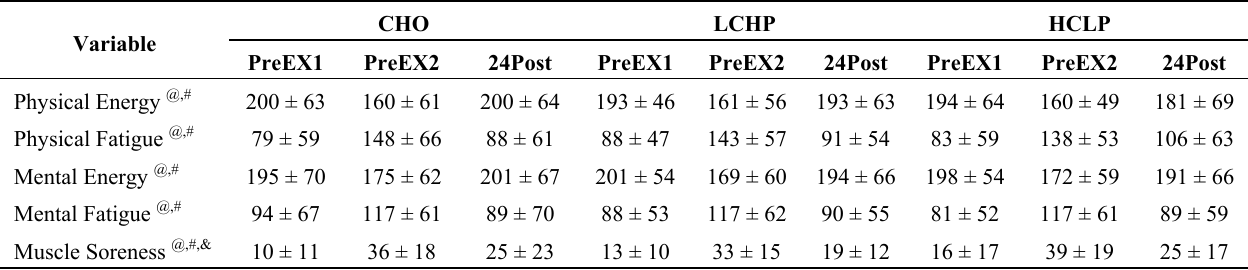
Table 3. Ratings of Physical and Mental Energy/Fatigue and Muscle Soreness (Mean ±